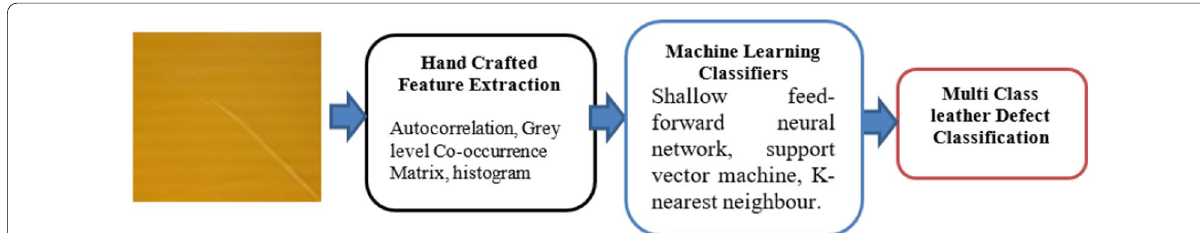
Fig. 6 Block diagram of Machine learning approach for multi class leather defect